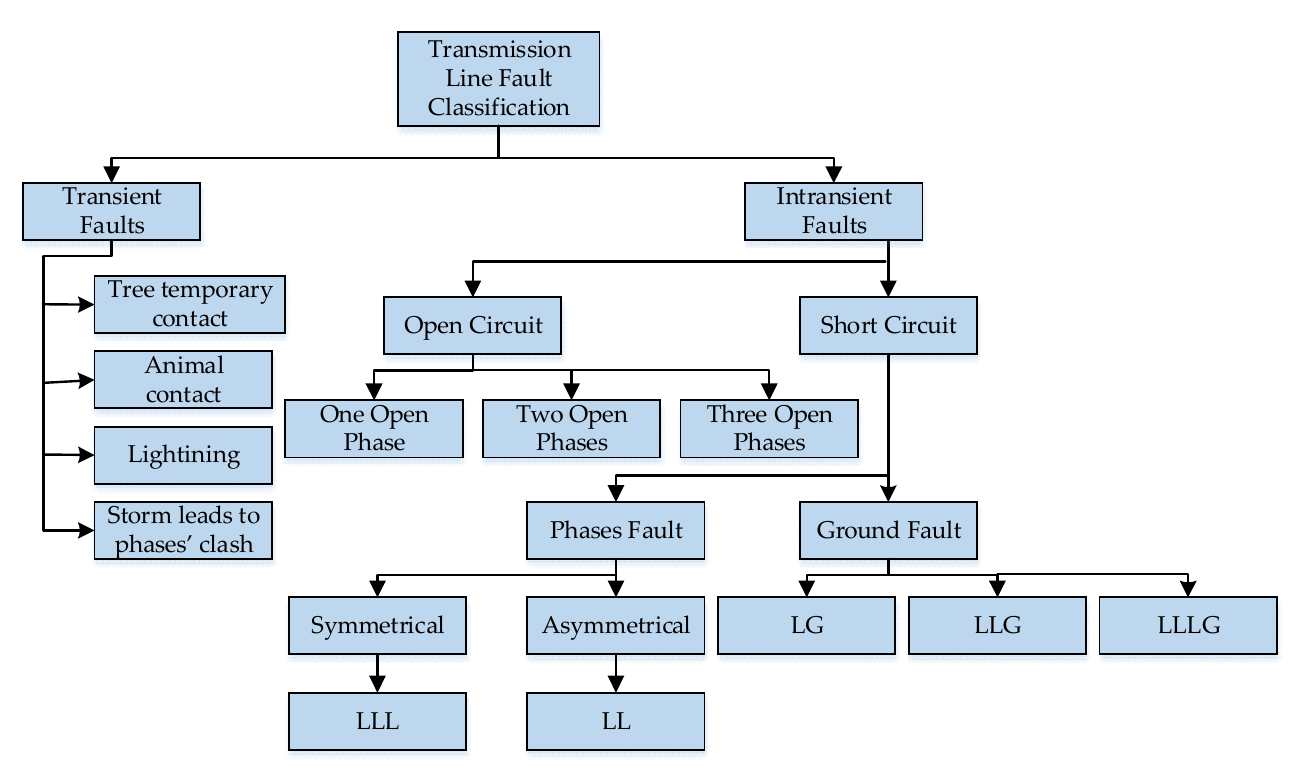
Figure 3. Classification of faults in overhead transmission lines.